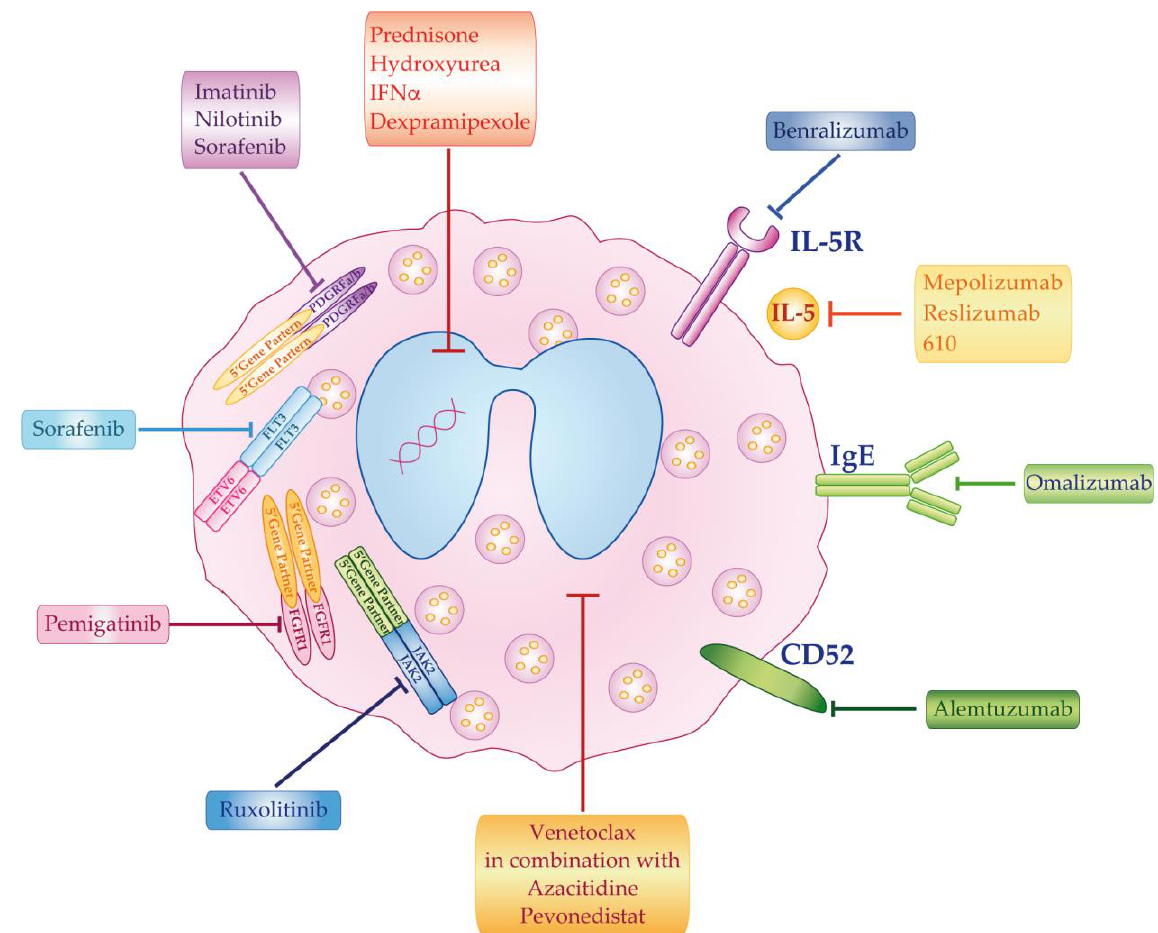
Figure 5. Working model depicting the mechanism of action of pharmacological agents used in hypereosinophilia disorders. Alemtuzumab = anti-CD52 monoclonal antibody; Benralizumab = anti-IL5-R monoclonal antibody; Dexpramipexole , Hydroxyurea and IFNα = cytotoxic agents ; Imatinib and Nilotinib = PDGFRs inhibitors; Pegatinib = FGFR1 inhibitor; Mepolizumab , Reslizumab and 610 = recombinant anti-IL5 humanized monoclonal antibody; Omalizumab = anti-IgE monoclonal antibody; Prednisolone = corticosteroid; Ruxolitinib = Jak2 inhibitor; Sorafenib = PDGFR α and FLT3 inhibitor; Venetoclax in combination with Azacitidine and Pevonedistat = chemotherapy regimens.